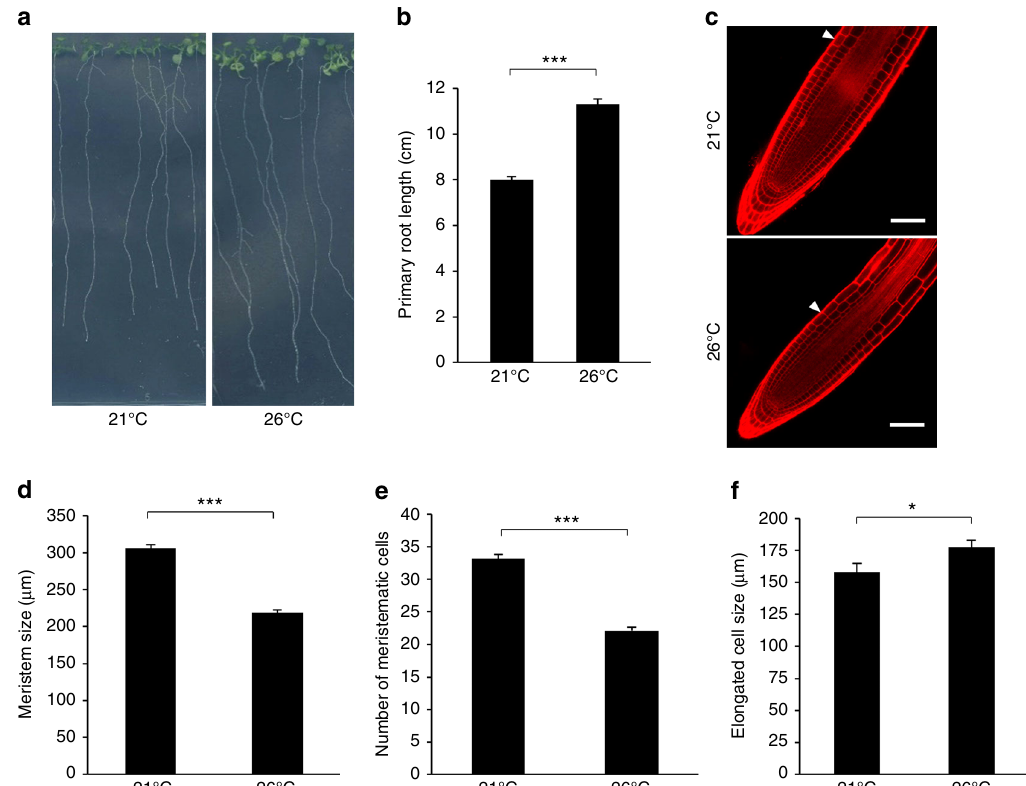
Fig. 1 Elevated ambient temperature impacts on root elongation. a Phenotype of 15-day-old wild-type plants grown at 21 or 26 °C under long days. Representative pictures are shown. b Primary root length of 15-day-old wild-type plants grown at 21 or 26 °C (mean ± s.d., n = 25). The asterisks indicate a statistically signi fi cant difference ( t -test, P < 0.0001). c Propidium iodide staining of wild-type plant roots grown as in a . Arrows represent the meristem boundary where cortical cells double their size. Scale bar , 50 µ m. d Quanti fi cation of meristem size, de fi ned by the distance from the quiescent center to the meristem boundary, in plants grown at 21 or 26 °C (mean ± s.d., n = 25). The asterisks indicate a statistically signi fi cant difference ( t -test, P < 0.0001). e Quanti fi cation of meristem cell number in plants grown at 21 or 26 °C (mean ± s.d., n = 25). The asterisks indicate a statistically signi fi cant difference ( t -test, P < 0.0001). f Quanti fi cation of differentiated root epidermal cell length (mean ± s.d., n = 25). The asterisk indicates a statistically signi fi cant difference ( t -test, P <